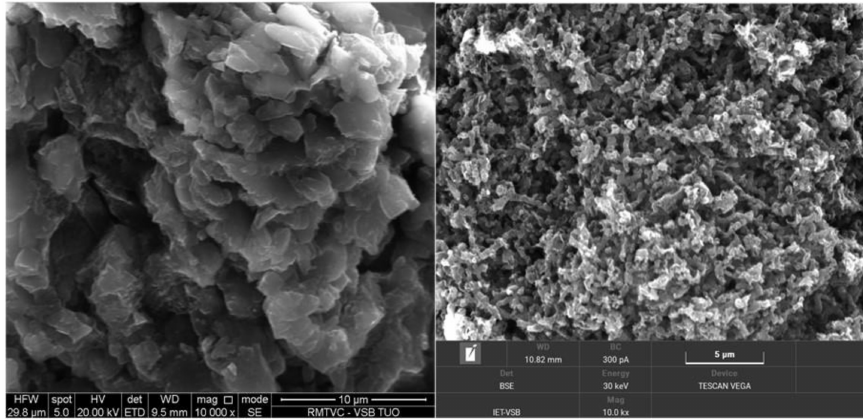
Figure 4. SEM micrographs of CN materials. ( left ) CN-M, ( right )